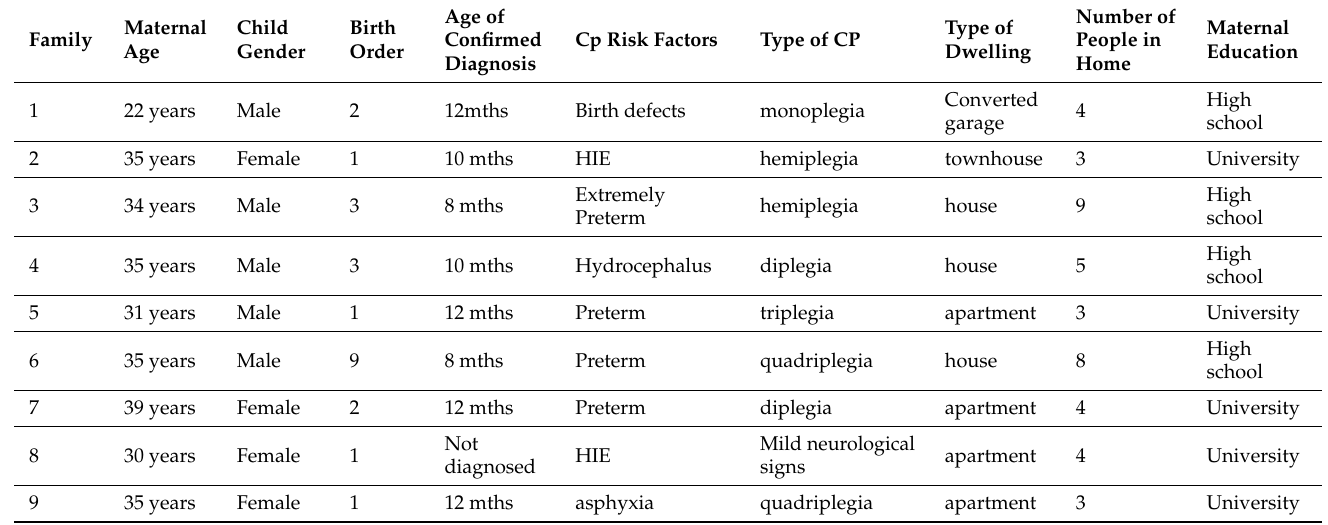
Table 2. Characteristics of participant